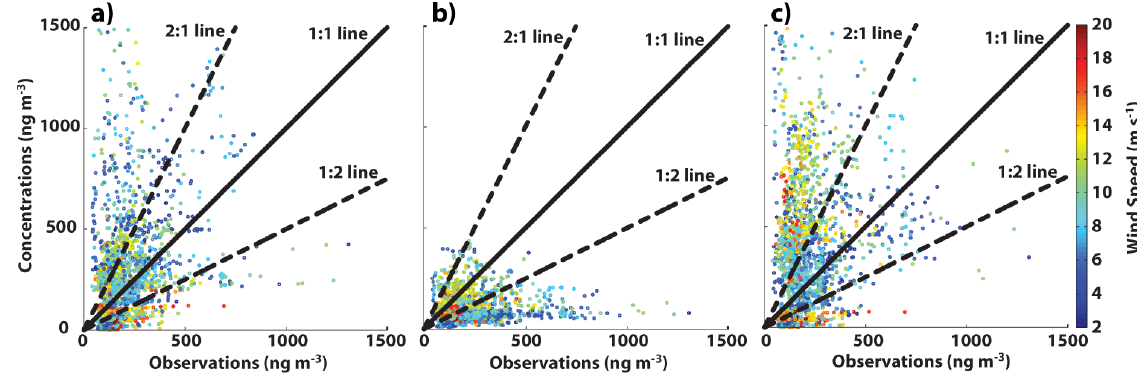
Fig. 5. Scatterplots of the 2009 hourly observed submicron OM concentration and predicted marine POA concentration from the (a) S08, (b) G11, and (c) Eq. (3) emissions at Mace Head. Data is color-coded by the hourly observed wind speed. 23( ∼ 1% of clean marine periods) observational datapoints with concentrations in excess of 1500ngm − 3 were